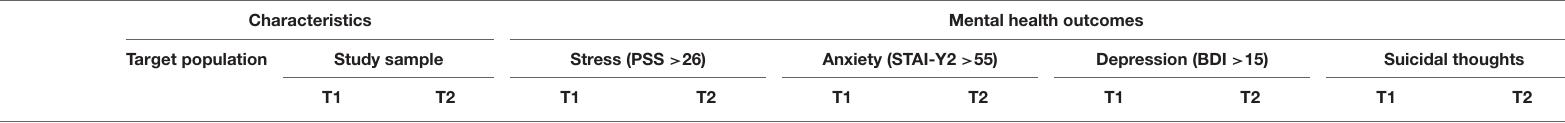
TABLE 1 | Crude and adjusted prevalence rates of mental health outcomes at T1 and T2 in the whole sample ( n = 68,891 at T1; n = 22,540 at T2) and detailed prevalence rates according to gender and